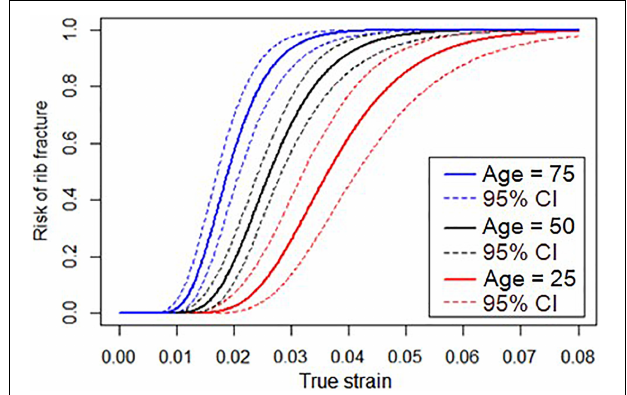
FIGURE 2 | Risk function relating true strain and risk of rib fracture for subjects who are 25, 50, and 75 years